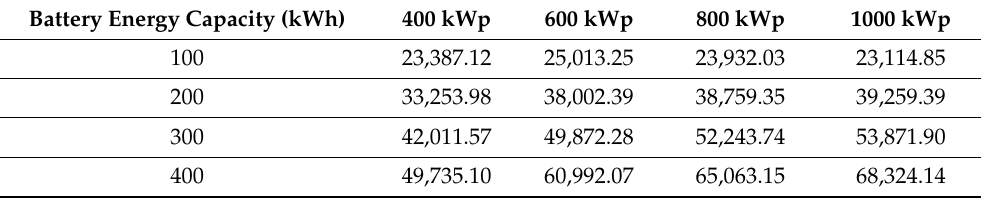
Table 5. Estimated annual amounts of energy in kWh possibly stored by the batteries. Battery Energy Capacity